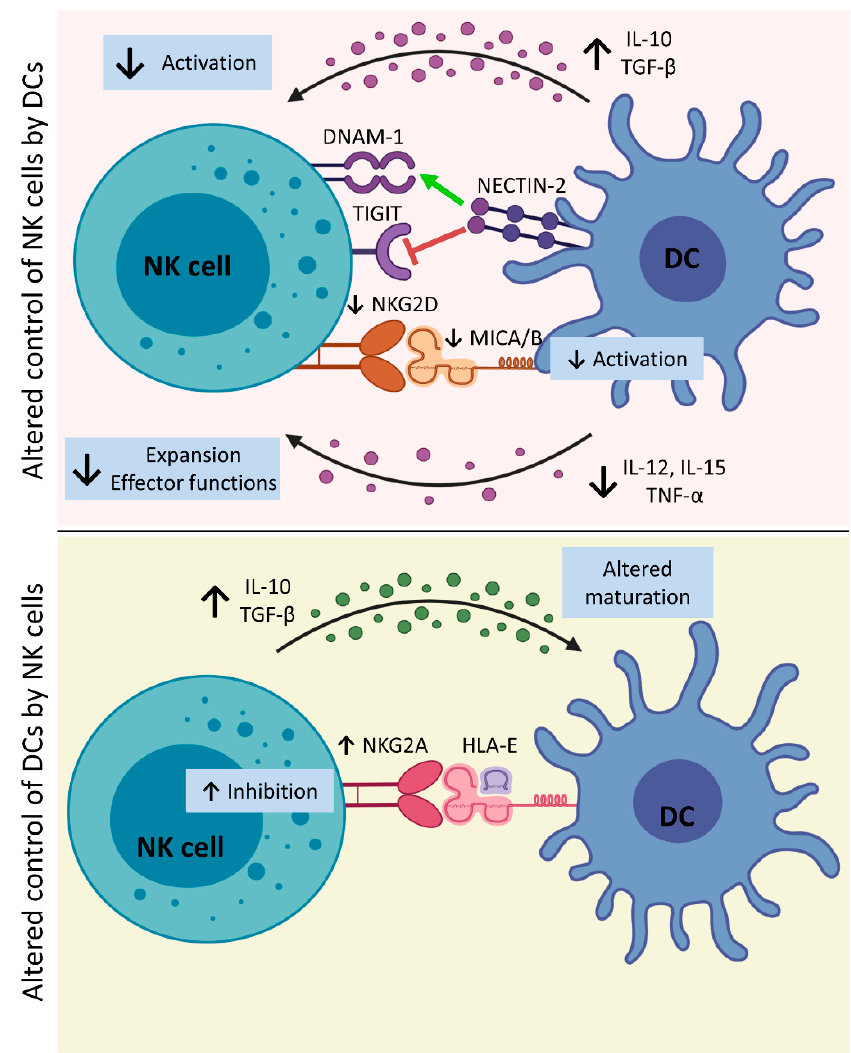
Figure 2. Altered DC–NK cell interplay in liver cancer. Upper panel: In the TME, DCs increase the secretion of IL-10 and TGF- β , which impair NK cell activation by the reduction of NKG2D expression on NK cells. Therefore, altered NKG2D–MICA/B interaction results in lower NK cell and DC activation. Moreover, the exposure to high levels of IL-10 and TGF- β induces a lower release of IL-12, IL-15, and TNF- α by DCs. In particular, impaired production of IL-15, causes the aberrant expression of MICA/B on DCs, and decreased expression of IL-12 by DCs induced by tumor AFP further harm NK cell activation. NK cell interaction by NECTIN-2 exposed on DCs can either block or increase NK cell activity through TIGIT or DNAM-1 interaction, respectively. Lower panel: Tumor-associated NK cells increase expressions of IL-10 and TGF- β that impair DC maturation, leading to the killing of iDCs by NK cells. Moreover, increased expressions of NKG2A on NK cells and HLA-E on DCs inhibit NK cell activity. [AFP, α -fetoprotein; DCs, dendritic cells; DNAM-1, DNAX Accessory Molecule-1 or CD226; HLA-E, Major Histocompatibility Complex, Class I, E; iDCs, immature dendritic cells; IL-10, interleukin 10; IL-12, interleukin 12; IL-15, interleukin 15; IL-18, interleukin 18; MICA/B, MHC class-I-related protein A/B; NK cells, natural killer cells; NECTIN-2, Nectin Cell Adhesion Molecule 2 or CD112; TGF- β , tumor growth factor β ; TIGIT, T cell immunoreceptor with Ig and ITIM domains; TME, tumor microenvironment; and TNF- α , tumor necrosis factor α ]. Created with BioRender.com (accessed on 16 March 2021).